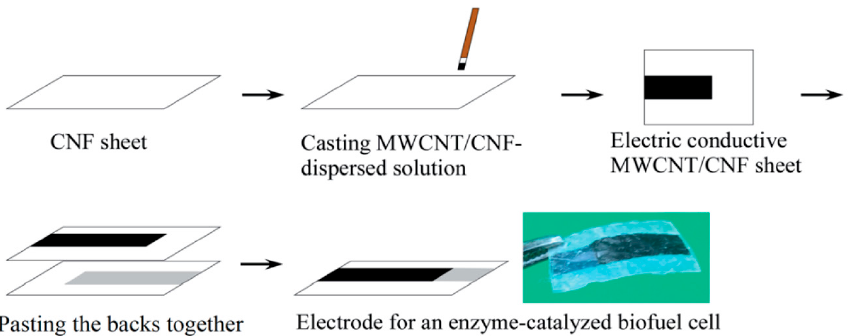
Figure33. Figure 33. Illustration of the cellulose nanofiber (CNF)-based electrode in an enzymatic BFC. Reproduced from [152] under Creative Commons Attribution Non-Commercial 3.0 Unported Licence.